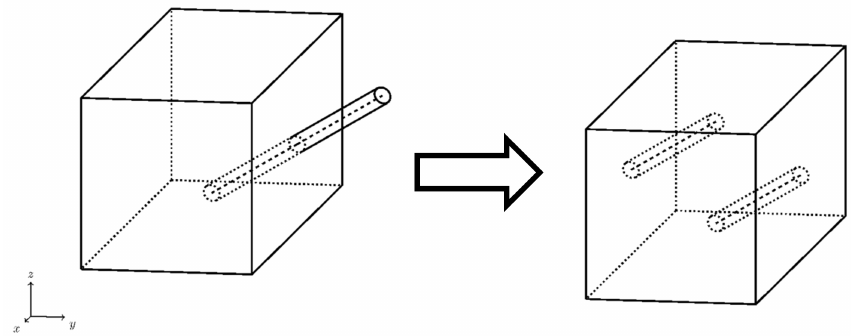
Figure 4. Enforcing periodicity of cylinder element by splitting and